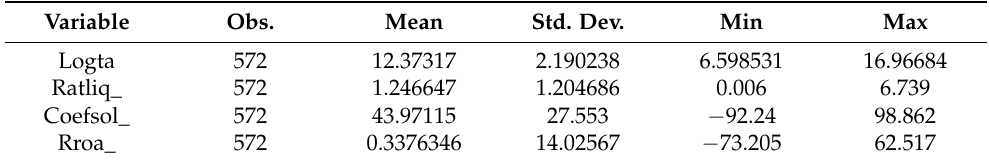
Table 8. Summary of control